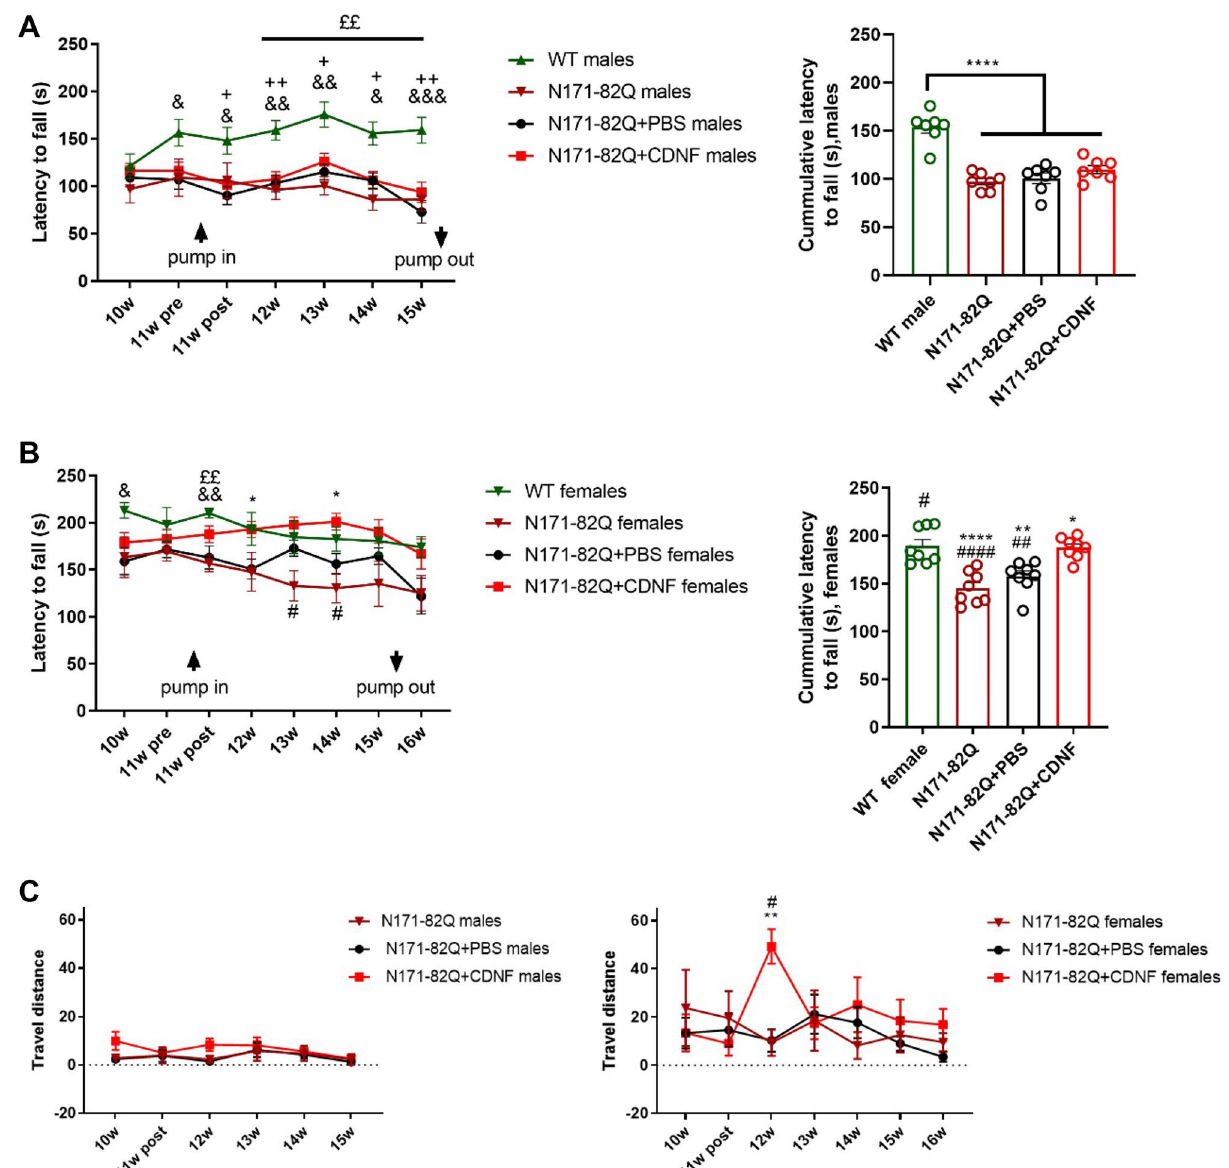
Figure 3. Motor presentation. Mice received a chronic infusion of CDNF- or PBS- into the right striatum. ( A ) Rotarod in N171-82Q male mice. There was not a significant improvement in motor performance between PBS-treated, CDNF-treated and untreated N171-82Q males. Healthy animals showed a significant difference from N171-82Q animals in motor performance and cumulative latency. &, comparison between WT and N171- 82Q + PBS males; + , comparison between WT and N171-82Q + CDNF males; £, comparison between WT and untreated N171-82Q males. Values are expressed as group mean ± SEM; * p < 0.05, ** p < 0.005, *** p < 0.0005, **** p < 0.0001; one-way ANOVA test. N number = 8–26 (N171-82Q groups) and n = 13 (WT group). ( B ) Rotarod in N171-82Q female mice. CDNF-treated N171-82Q females showed a statistically significant effect on motor coordination compared to vehicle-treated groups and untreated N171-82Q animals. Cumulative results showed a significant improvement in motor coordination in CDNF-treated and healthy animals compared to PBS-treated and untreated N171-82Q females. *, comparison between N171-82Q + CDNF and N171-82Q + PBS females; #, comparison between N171-82Q + CDNF and untreated N171-82Q females; &, comparison between WT and N171-82Q + PBS females; £, comparison between WT and untreated N171-82Q females. Values are expressed as group mean ± SEM. **** p < 0.0001, ** p < 0.01, * p < 0.05, repeated-measures ANOVA test, one- way ANOVA test. N number = 6–19 (N171-82Q groups) and n = 6 (WT group). ( C ) Travel distance in the balance beam test. The CDNF-treated female group showed a statistically significant positive effect on balance performance one week after minipump installation in comparison with the vehicle group. Values are the means ± SEMs. ** p < 0.01, * p < 0.05, mixed-effect ANOVA test, Sidak’s post hoc test. N number per group =